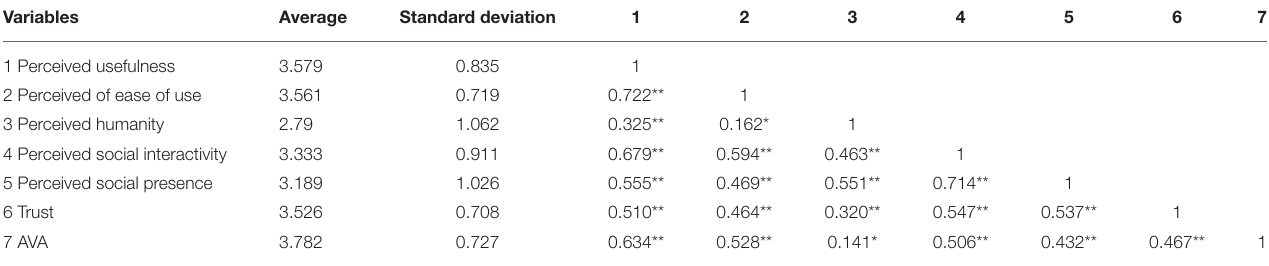
TABLE 2 | Descriptive statistics results with correlation coefficients.